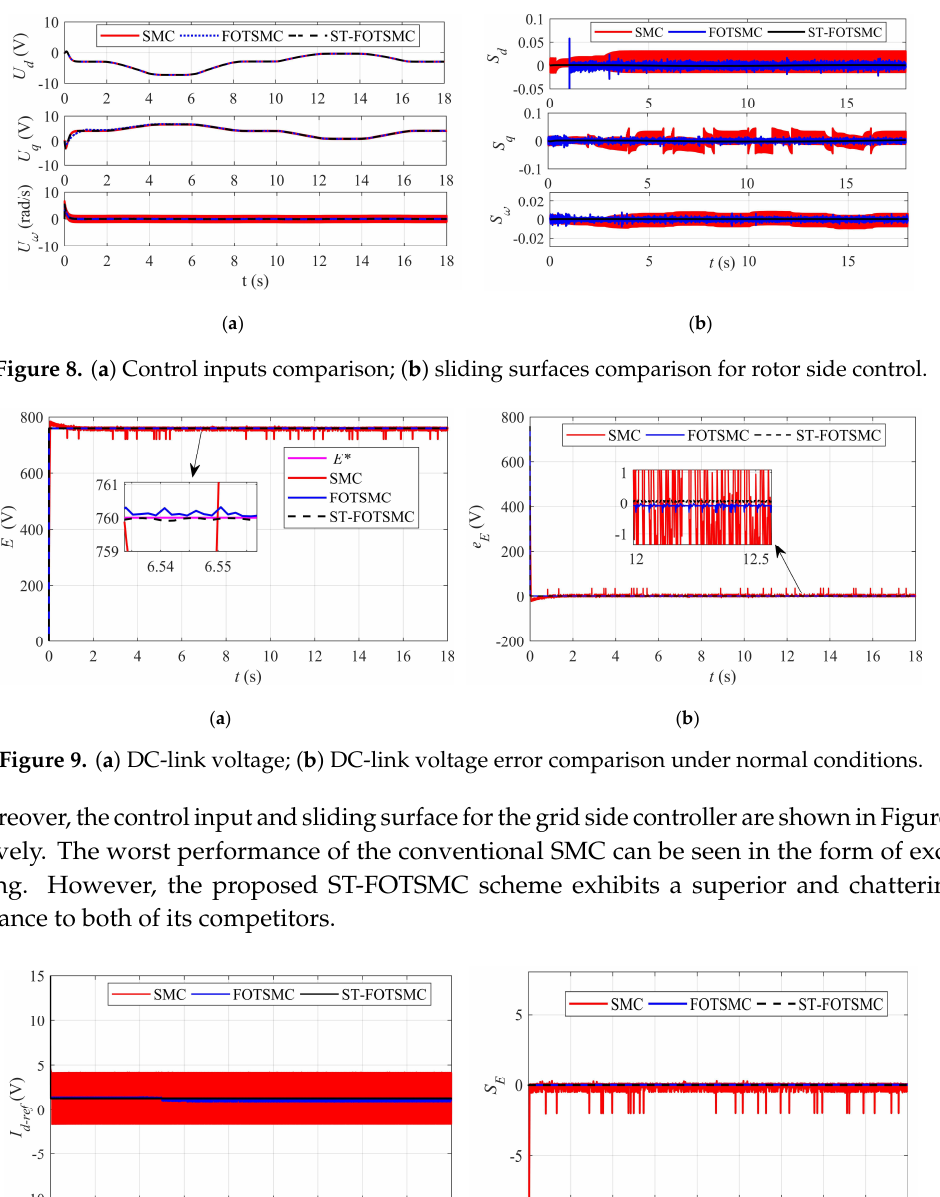
Figure 10. ( a ) Control input for grid side control; ( b ) grid side control sliding surface.